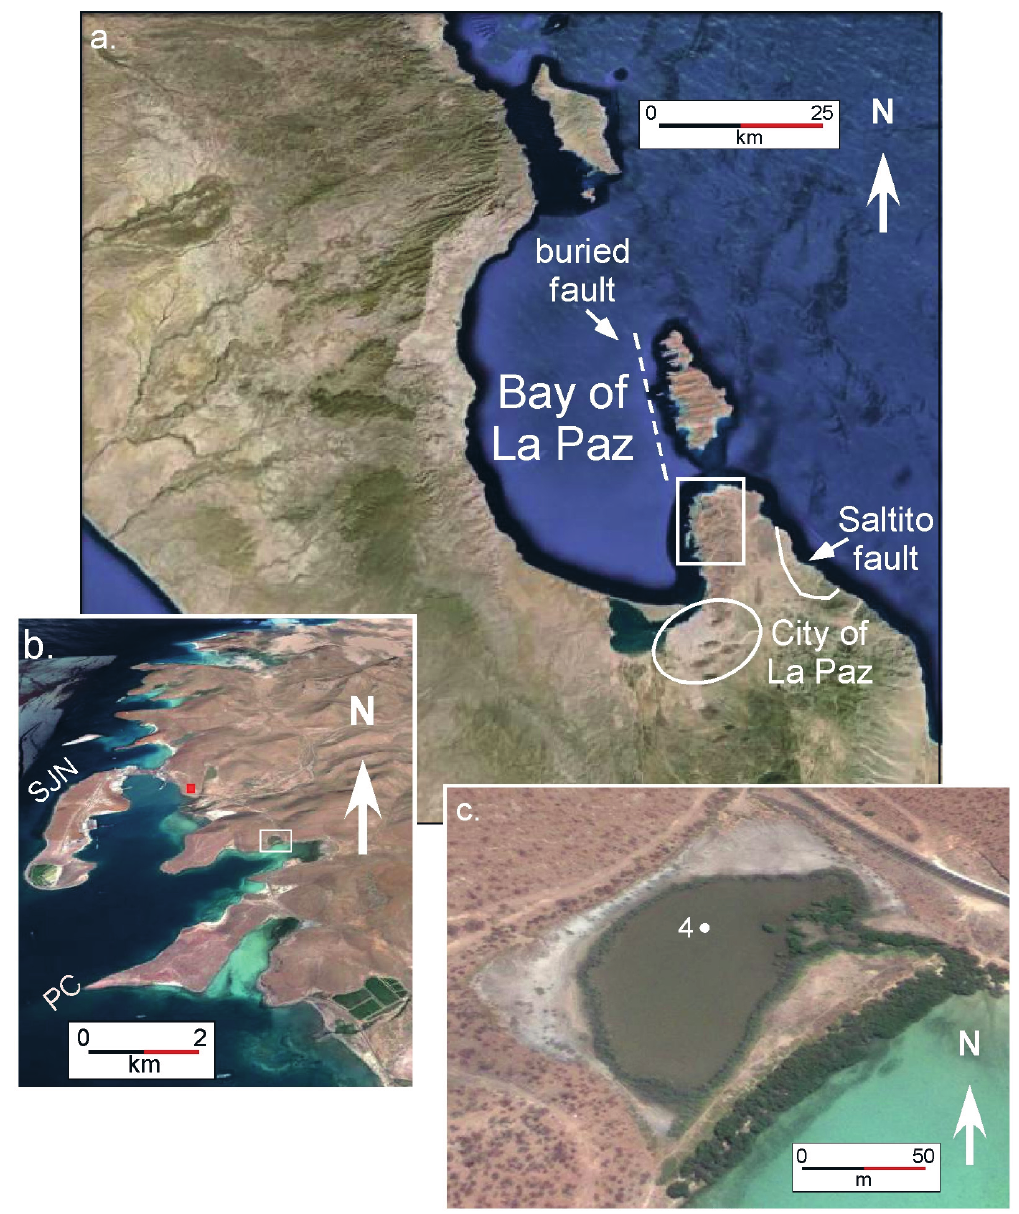
Figure 2. Location of study site. Displayed on Google Earth imagery are ( a ); the Bay of La Paz, the city of La Paz, the Saltito Fault and the buried fault identified by [21,22] as occurring along the western flanks of the islands on the eastern edge of the bay. The area marked by the white square is expanded in ( b ); which displays the location of the two peninsulas surrounding Estero de Bahia Falso, our study site (white square) and the Pichilingue tidal gauge (red square). Estero de Bahia Falso is shown in greater detail in ( c ), with the location of core 4 marked by a white